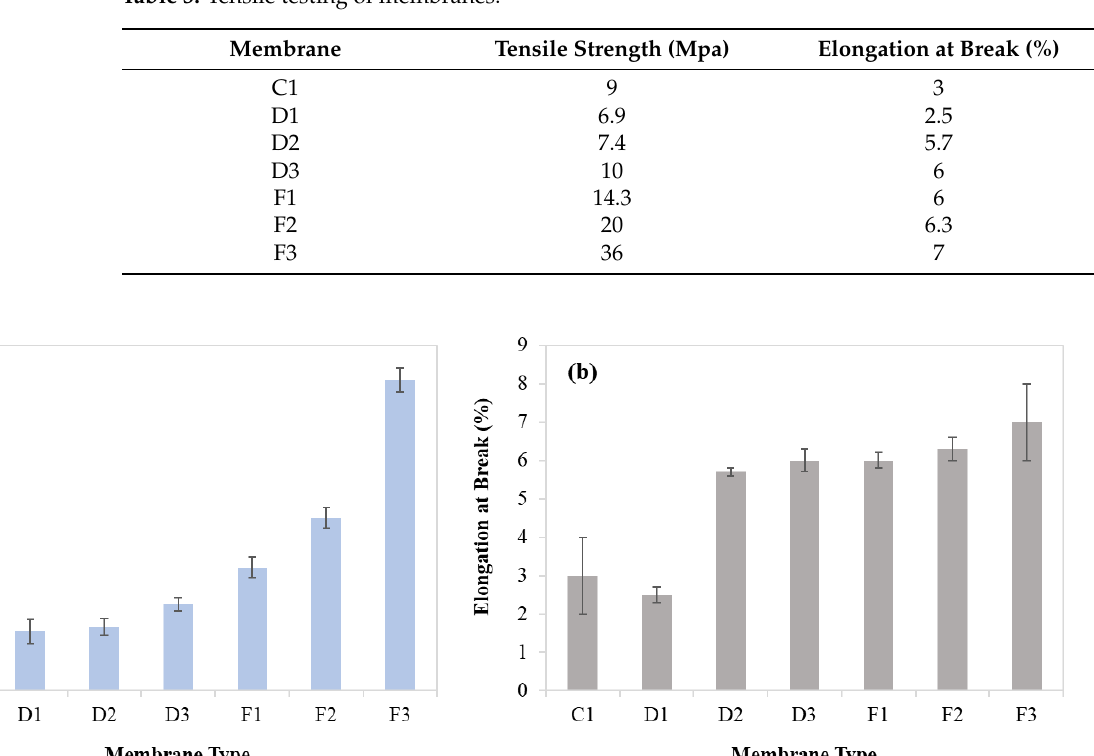
Table 3. Tensile testing of membranes.